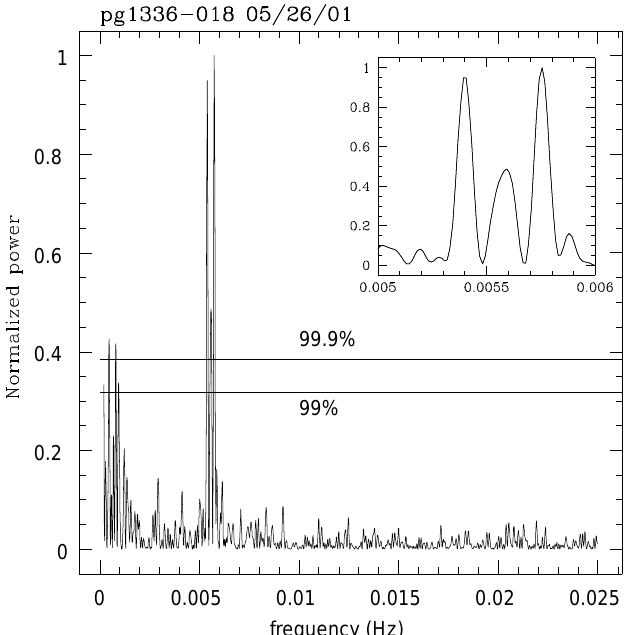
Fig. 4. The Scargle periodogram and the confidence levels for the highest peaks for the night of May 26,